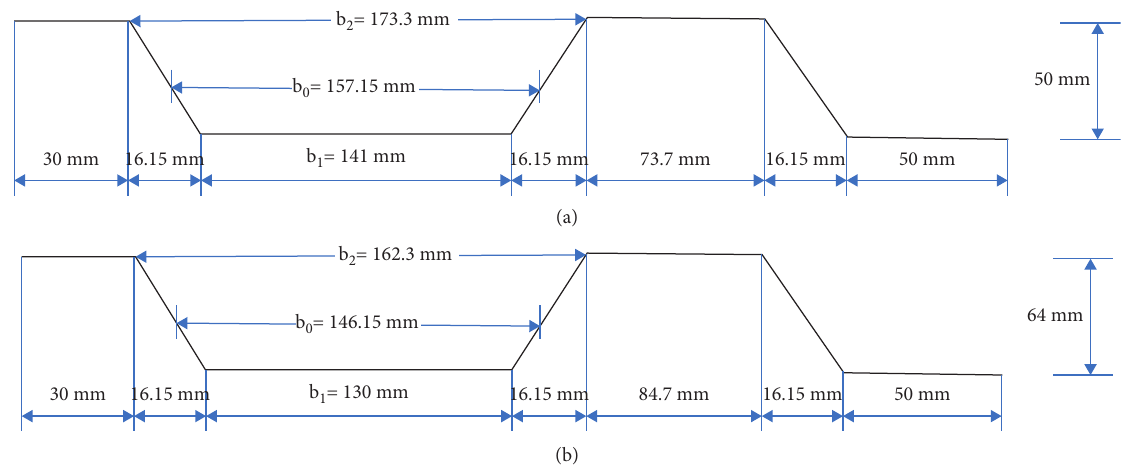
Figure 1: Definition of symbols for open through profiled steel sheeting including dimensions.